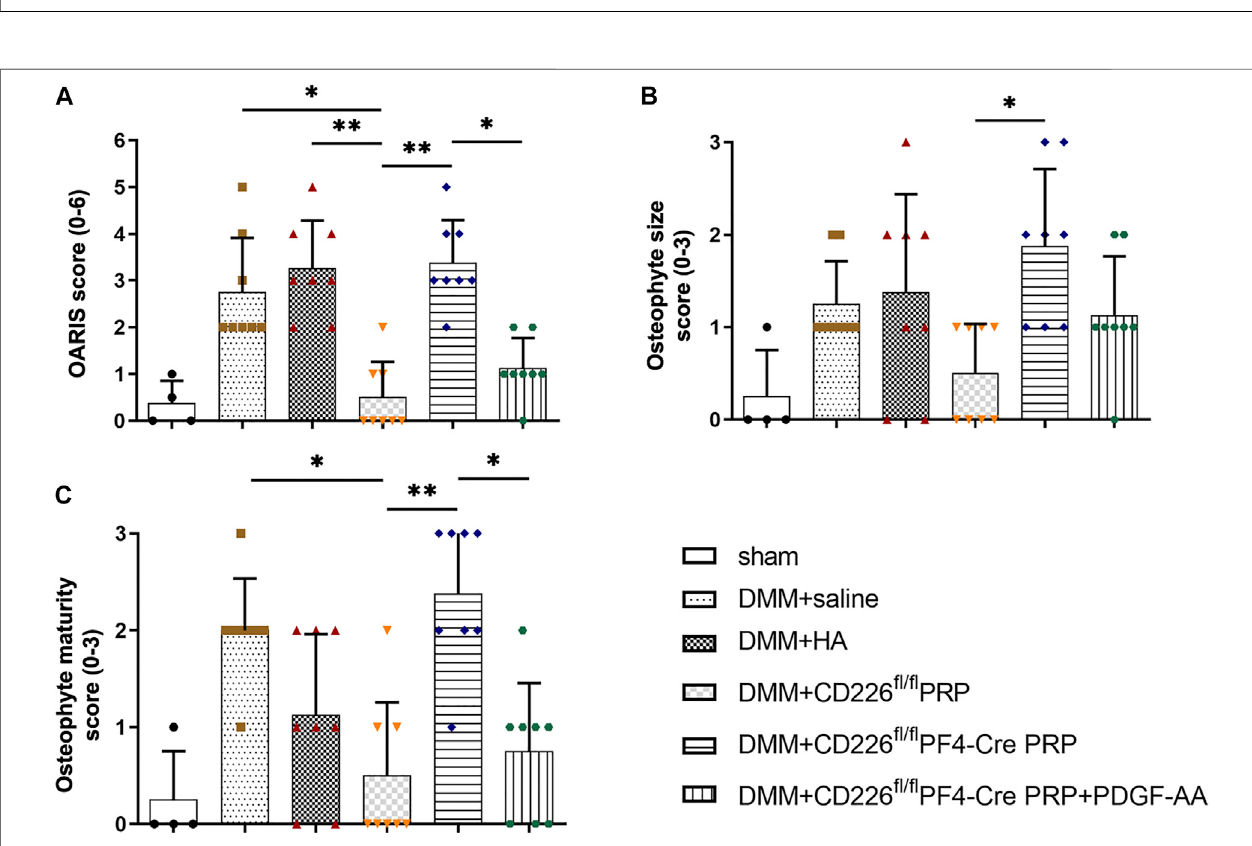
FIGURE6| HistologicalscoringofPRP-treatedDMMmice. (A) OARIS-modi fi edMankinscoreofarticularcartilage. (B) Osteophytesizescoresand (C) Osteophyte maturityscores.Thescore-relateddatawereanalyzedbyKruskal – WallistestaccompaniedwithDunn ’ smultiplecomparisontest.* p < 0.05,** p < 0.01,ns (cid:1) nostatistical signi fi cance. Supplementary Figure S1 . Flow cytometry analysis for the expression of CD226 in splenocyte from CD226 fl / fl and CD226 fl / fl PF4-Cre mice. (A) Gating strategy for fl ow cytometricanalysisofsplenocyte subsets. (B) Representative image of CD226 expression levels in Bcells, Tcells, NK cells, CD11b + myeloid cells and CD11c + DC. Supplementary Figure S2 . Other parameter detected after platelet CD226 de fi ciency in mice. (A) Routine blood test of the hemoglobin (HGB), red blood cell (RBC) number, and white blood cell (WBC) number. (B) Area of total dense-granule per platelet and average area of dense-granule per platelet in two groups. Statistical signi fi cance between groups was analyzed using independent-sample t -tests with two-tailed p value. ns (cid:1) no statistical signi fi cance.